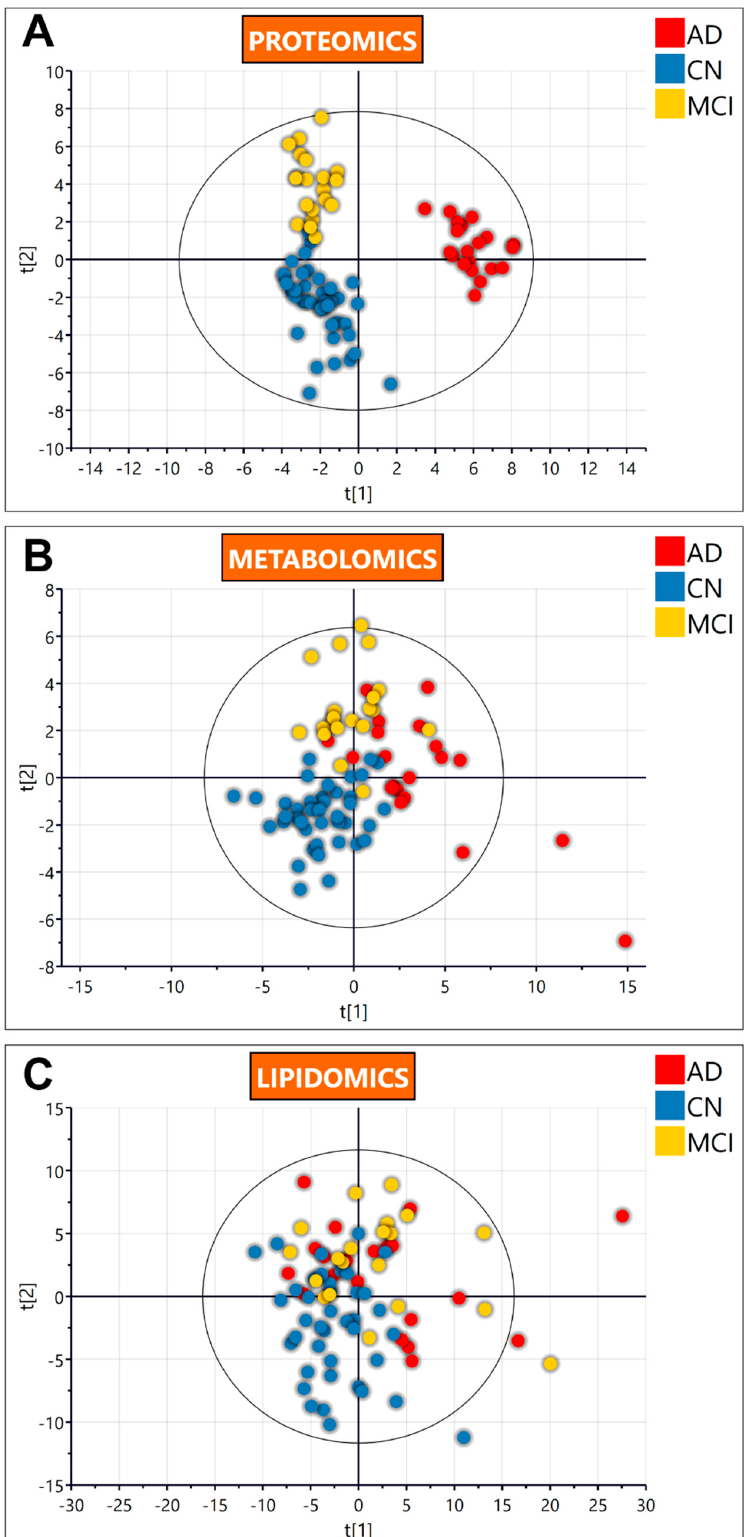
Figure 1. Partial least squares-data analysis (PLS-DA) score scatter plots for the proteomics ( A ), metabolomics ( B ) and the lipidomics ( C ), discriminating the three groups. A legend for the colour is provided in each plot. Abbreviations: AD, Alzheimer’s disease; CN, cognitively normal; MCI, mild cognitive impairment.